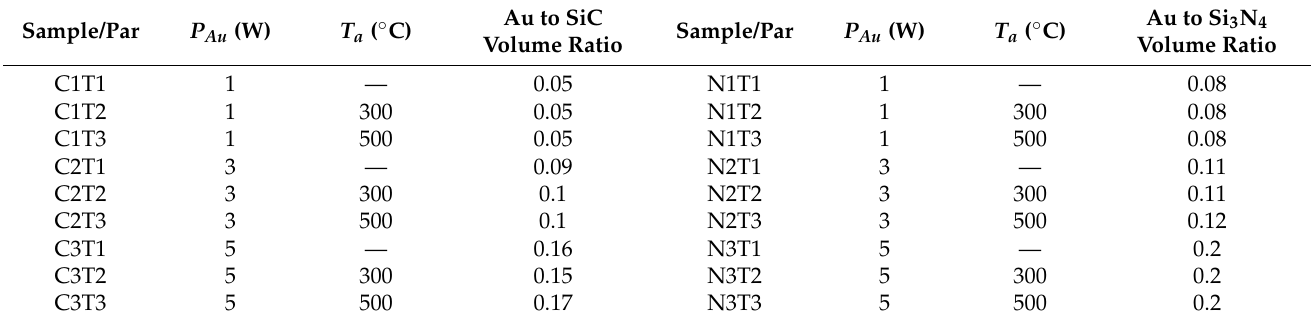
Table 1. Deposition parameters of the films. P Au indicates the sputtering power of Au, T a is the annealing temperature, and Au to SiC/Si 3 N 4 shows the targeted volume ratio of the Au to the